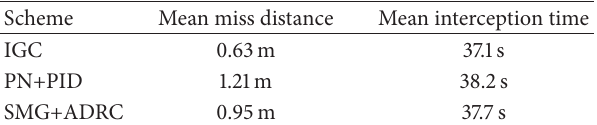
Table 1: Mean miss distance and interception time of the three schemes in Scenario 1.